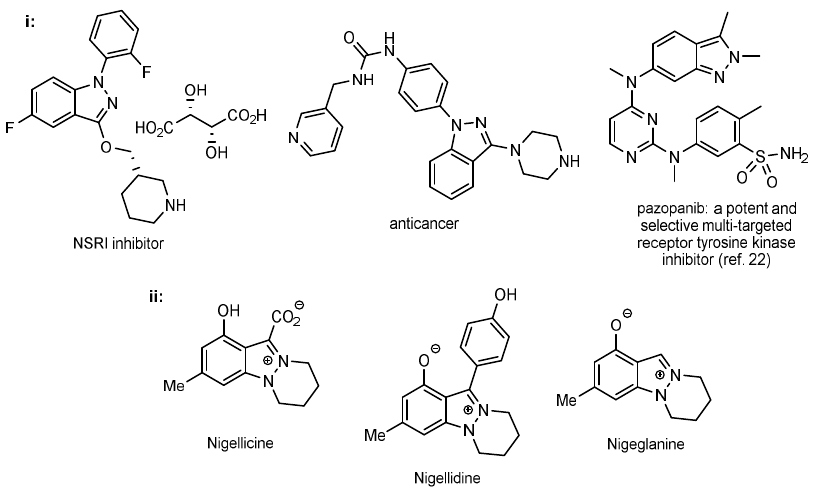
Figure 1. ( i ) Indazole derivatives with biological activity; ( ii ) Natural products of indazole alkaloids.